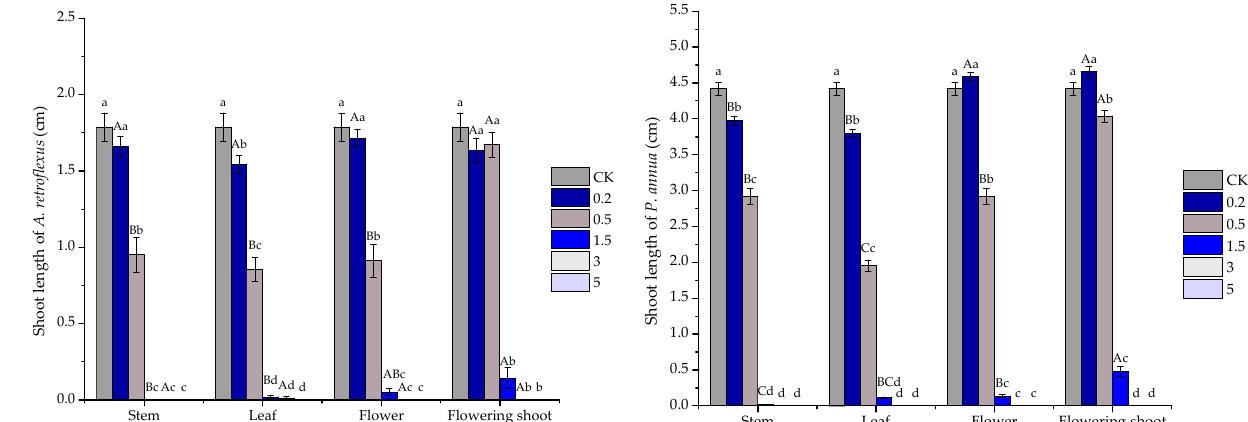
Figure 3. Phytotoxic effect of stem, leaf, flower and flowering shoot volatile oils of S. kaschgaricum on shoot development of A. retroflexus and P. annua . Each value is the mean of five replicates ± SE ( n = 50). Different lowercase letters (a, b, c, etc.) indicate significant differences among different concentrations (0 mg/mL(CK), 0.2 mg/mL, 0.5 mg/mL, 1.5 mg/mL, 3 mg/mL and 5 mg/mL) of the same oil treatments at p < 0.05 level according to Fisher’s LSD test, and different uppercase letters (A, B, C, etc.) indicate significant differences among stem, leaf, flower and flowering shoot volatile oils at the same concentration (Fisher’s LSD test, n = 50, p < 0.05).